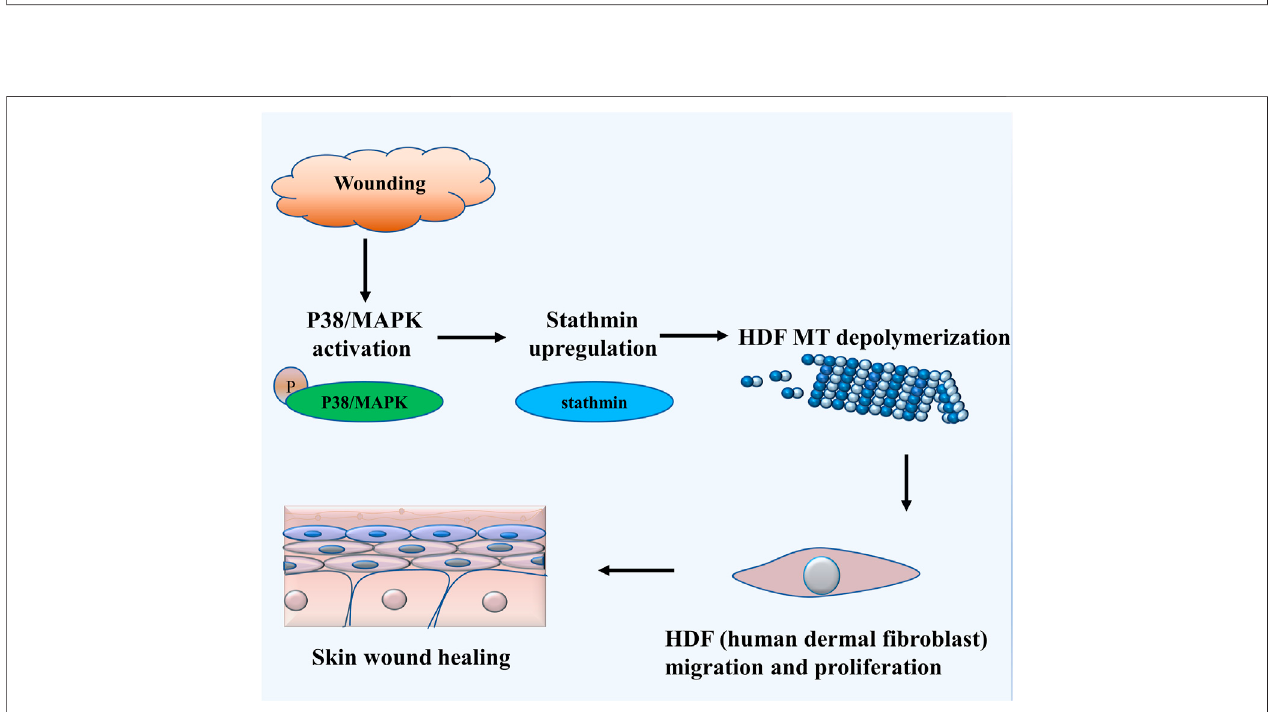
FIGURE 6 | total cells (blue). Bar, 20 µm. (I) For the tubulin immuno fl uorescence images of MTs, cells were transfected or cotransfected with siSTMN or MKK6(Glu). These inserts show high-magni fi cation images of the peripheral MT network. Bar, 10 µm. (J) Cell proliferation was detected after the HDF was transfected or cotransfected with siSTMN or MKK6(Glu) using the CCK-8 assay ( n (cid:1) 10). The results are shown as the means ± SEM. * p < 0.05 was considered to be signi fi